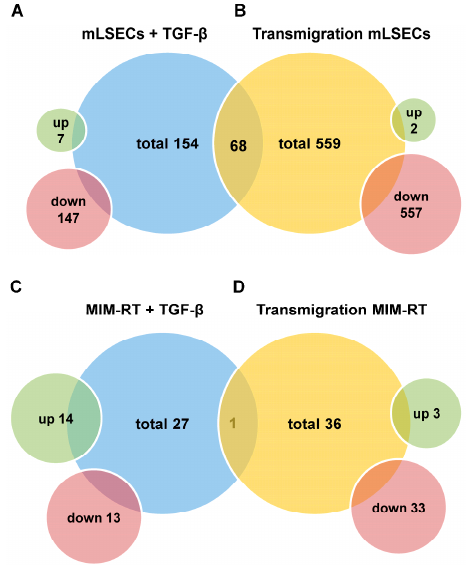
Figure 3. Analysis of protein expression in stable isotope labelling with amino acids (SILAC)-labeled individual and transmigrating cells by mass spectrometry. ( A ) Total number of proteins whose expression was changed in mLSECs treated with 2.5 ng/mL TGF- β 1 versus those treated with 10 µ M LY2109761; ( B ) Total number of proteins whose expression was altered in mLSECs during transendothelial migration; ( C ) Total number of proteins whose expression was changed in MIM-RT cells treated with 2.5 ng/mL TGF- β 1 versus those treated with 10 µ M LY2109761; ( D ) Total number of proteins whose expression was changed in MIM-RT cells during transendothelial migration.